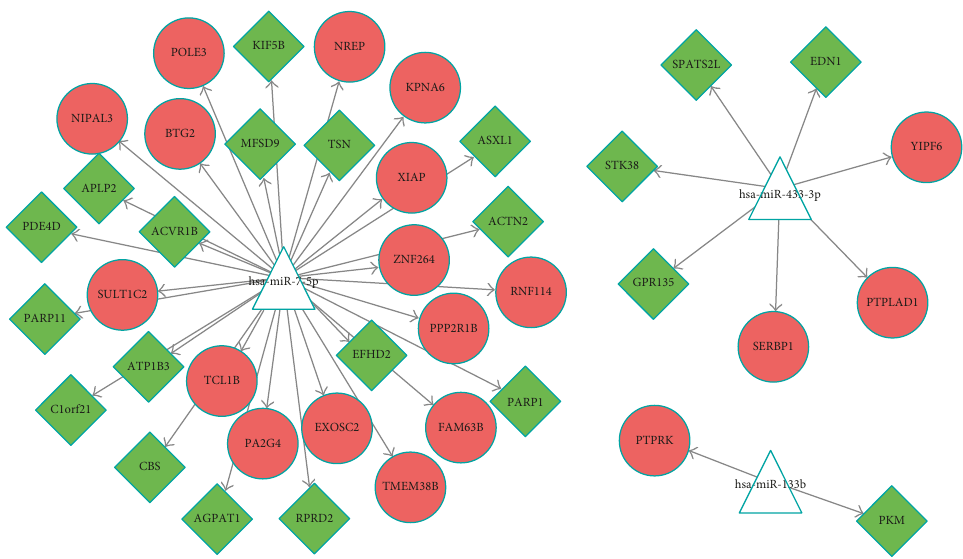
Figure 5: MicroRNA- (miRNA-) target regulatory networks of differentially expressed genes (DEGs). Triangles represent miRNAs, red circles represent upregulated DEGs, and green diamonds represent downregulated